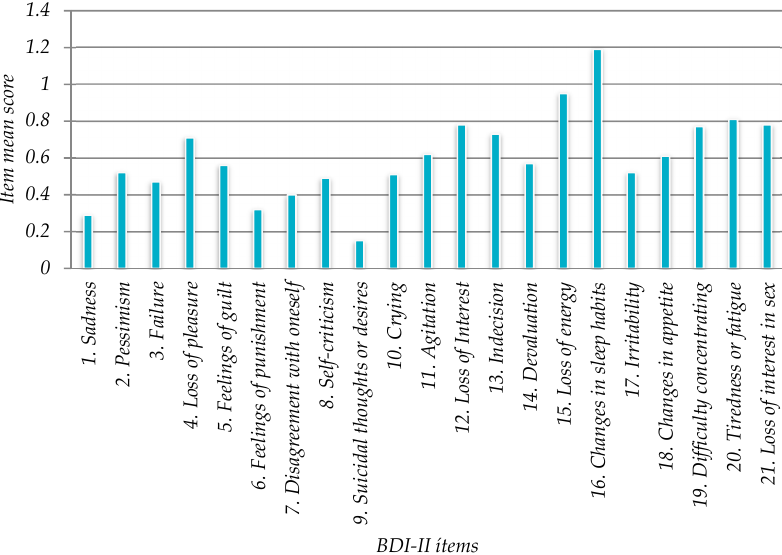
Table 6. Kruskal-Wallis analysis of faculty organizational factors.